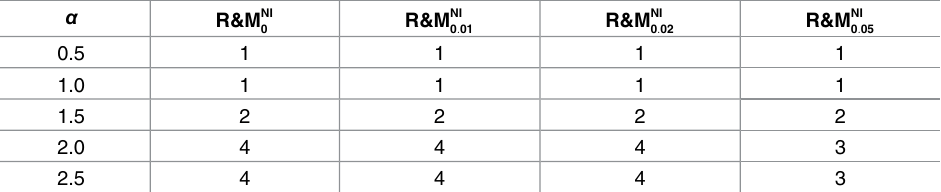
Table 6. Number of latent classesin Hb data for different α and different cut-offs ( ψ ).